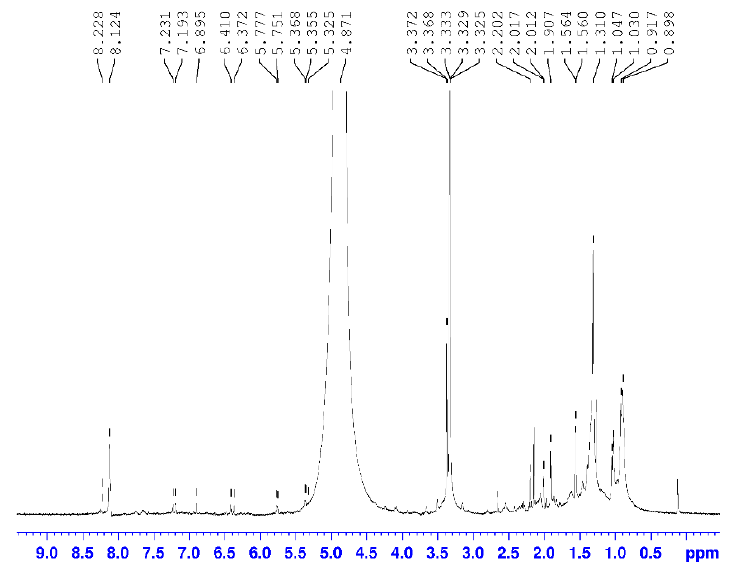
Table 1. Spectroscopic characterization by 1 H NMR of extract AM07AC.